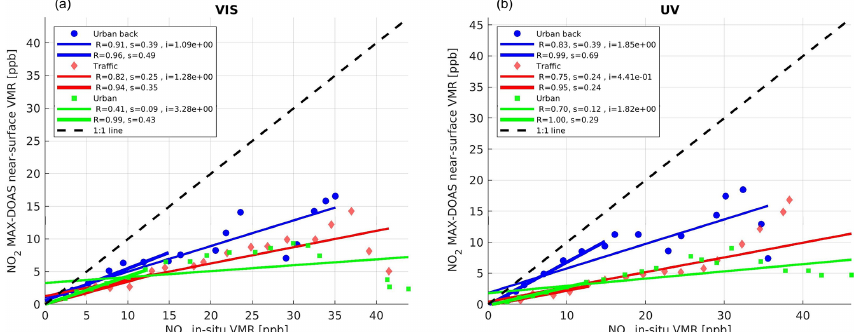
Figure 11. Scatter plots of binned MAX-DOAS and in situ NO 2 near-surface VMR in the (a) visible and (b) UV channels. The solid thick lines are the regression analysis results for the 0–12ppb in situ NO 2 concentration